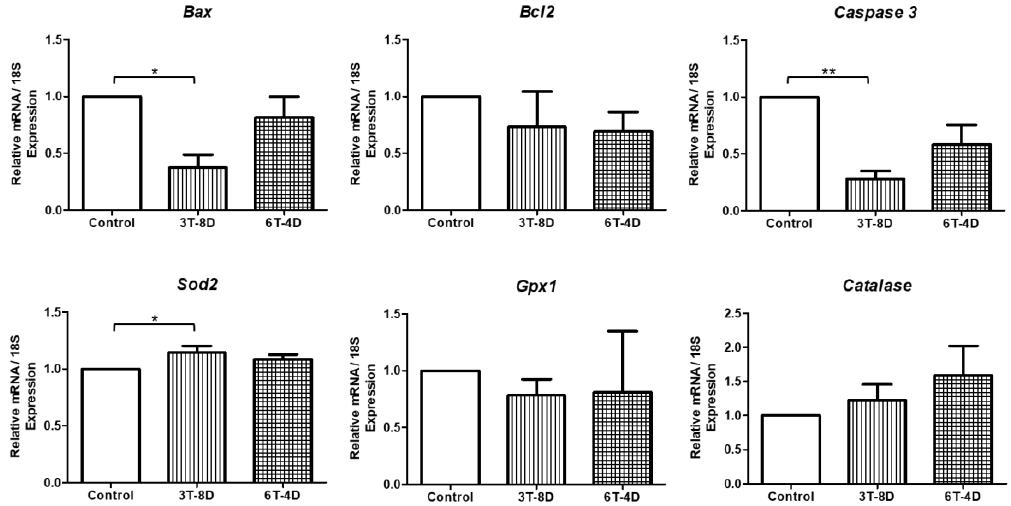
Figure 8. Relative expression to 18S of apoptosis and oxidative stress-related genes from the uterus of control and groups of human adipose-derived stem cell conditioned medium (ASC-CM) intravenous injection to 6-month-old ICR mice. Data are expressed as the mean ± standard error of the mean (SEM). * p < 0.05, ** p < 0.01. 4D-6T, six times injection in four day intervals; 8D-3T, three times injection in eight day intervals.